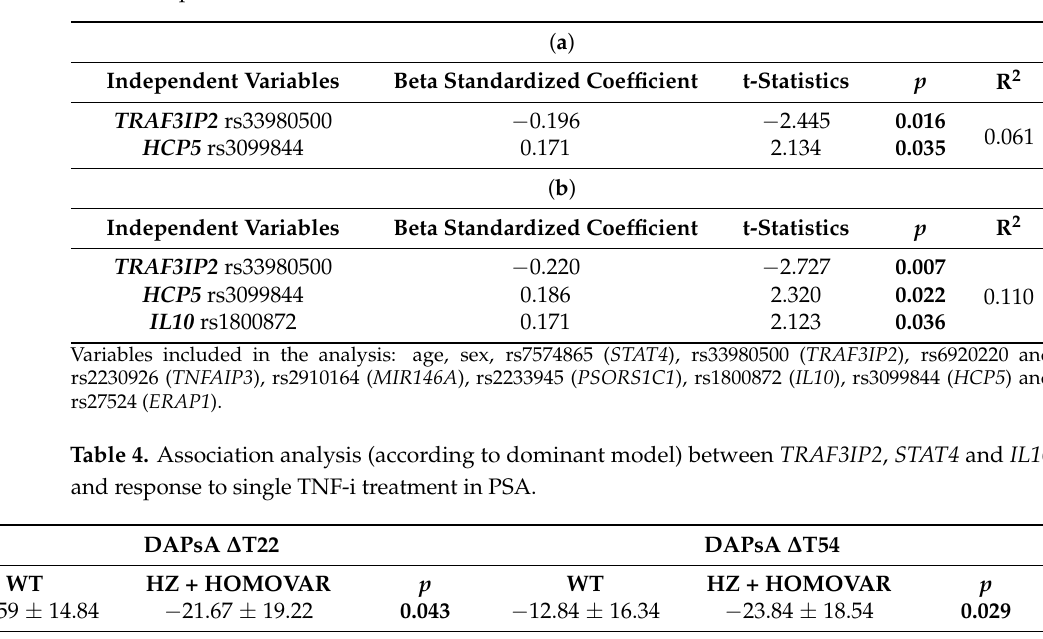
Figure 2. Mean differences of TJ ( A ) and SJ ( B ) values in the genotypic classes for TRAF3IP2 SNP. TJ = tender joint; SJ = swollen joint; Wt = wild-type genotype; Hz = heterozygous genotype; Homo var = homozygous genotype. Table 3. ( a ) Final model of multiple linear regression analysis by stepwise method for ∆ T22 as dependent variable. ( b ) Final model of multiple linear regression analysis by stepwise method for ∆ T54 as dependent variable.